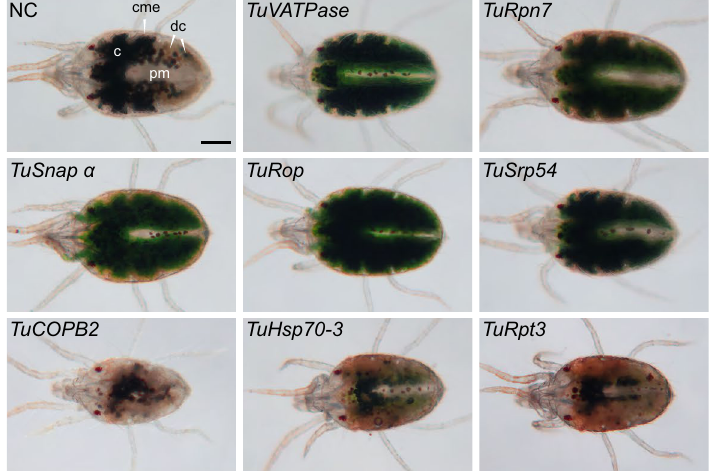
Figure 1. Mite body phenotypes upon dsRNA treatment. Two-spotted spider mites, T. urticae , are characterised by the presence of two dark spots, see NC, when observed under bright field. Spots are formed by the accumulation of dark digestive cells (dc) at the anterior of the midgut caeca (c) that can be seen through the semi-transparent cutile. Mites treated with dsRNAs targeting TuVATPase , TuRpn7, TuSnap α , TuRop and TuSrp54 have a dark body phenotype characterized by the accumulation of a dark green pigment in the caeca lumen. Mites treated with dsRNAs targeting TuCOPB2, TuHsc70-3 and TuRpt3 displayed a spotless phenotype, characterized by the absence of the accumulation of black digestive cells. caeca (c); caecal midgut epithelium (cme); posterior midgut (pm); digestive cells (dc). Scale bar: 100 μm.